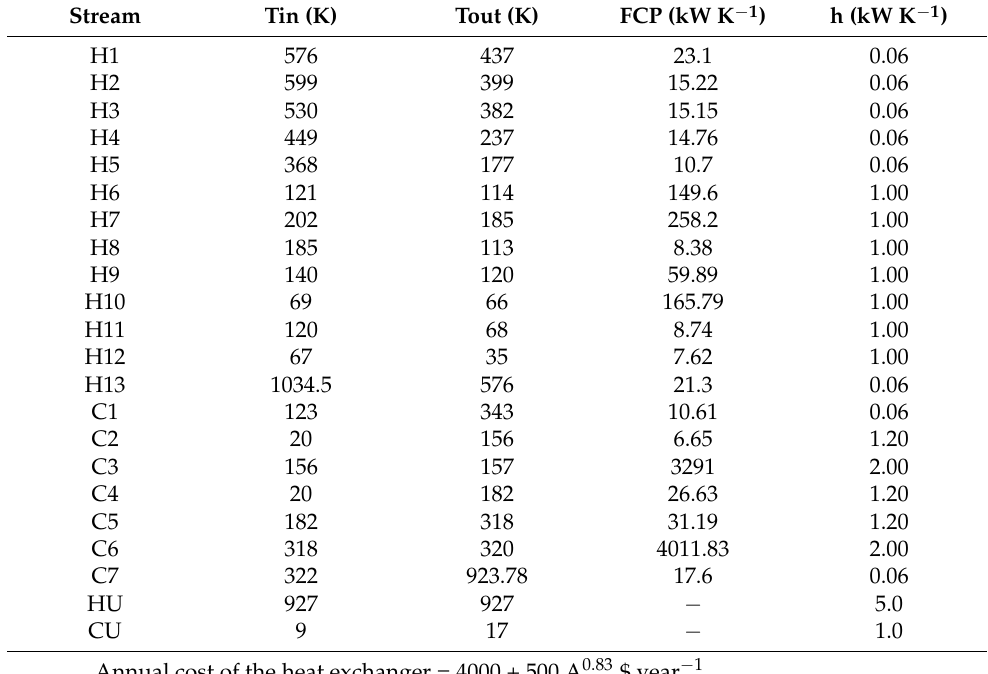
Table 1. Flow parameters of Case